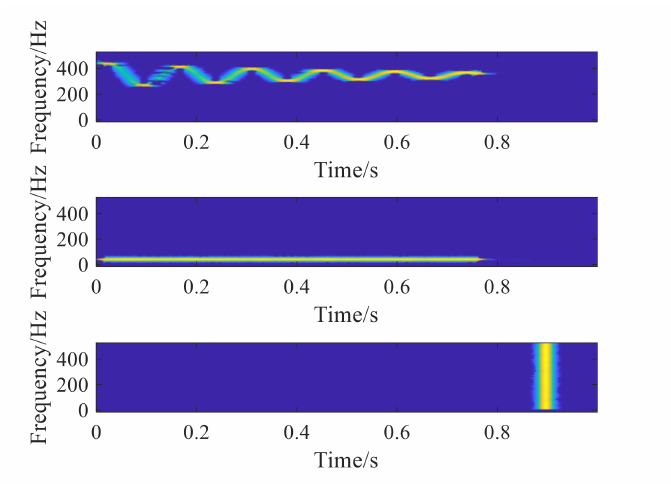
Figure 3. The TFR obtained by short-time Fourier transform (STFT) and reassignment vector (RV) method. ( a ) TFR obtained by STFT. ( b ) TFR obtained by the proposed method.